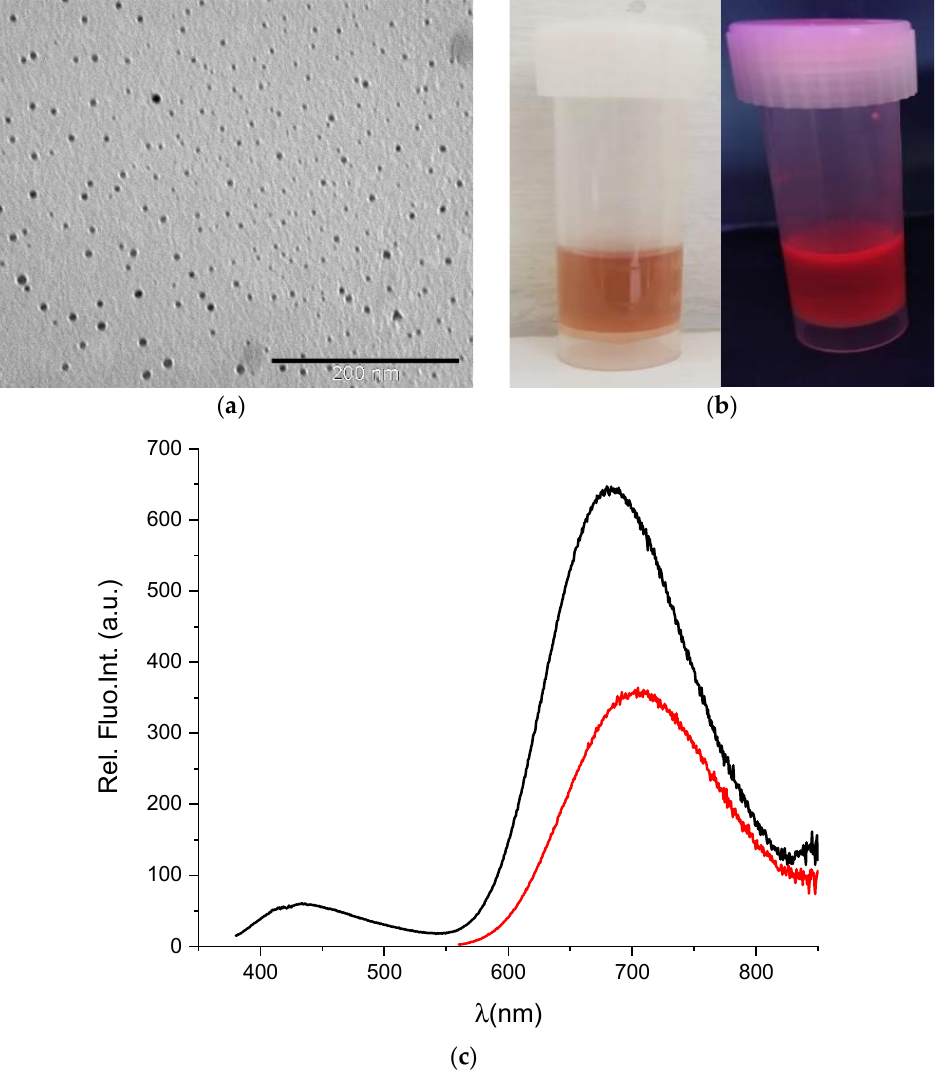
Figure 1. ( a ) TEM image of prepared AuNC@BSA; ( b ) photographs of red-shifted AuNC@BSA stock solutions in water under visible and UV light; ( c ) fluorescence emission spectra ( black line— λ exc = 365 nm; red line— λ exc = 540 nm) of AuNC@BSA in water ( c (BSA, AuNC@BSA) = 0.715 µM or c(Au 25 , AuNC@BSA) = 0.379 µmol dm − 3 ) at 298 K.